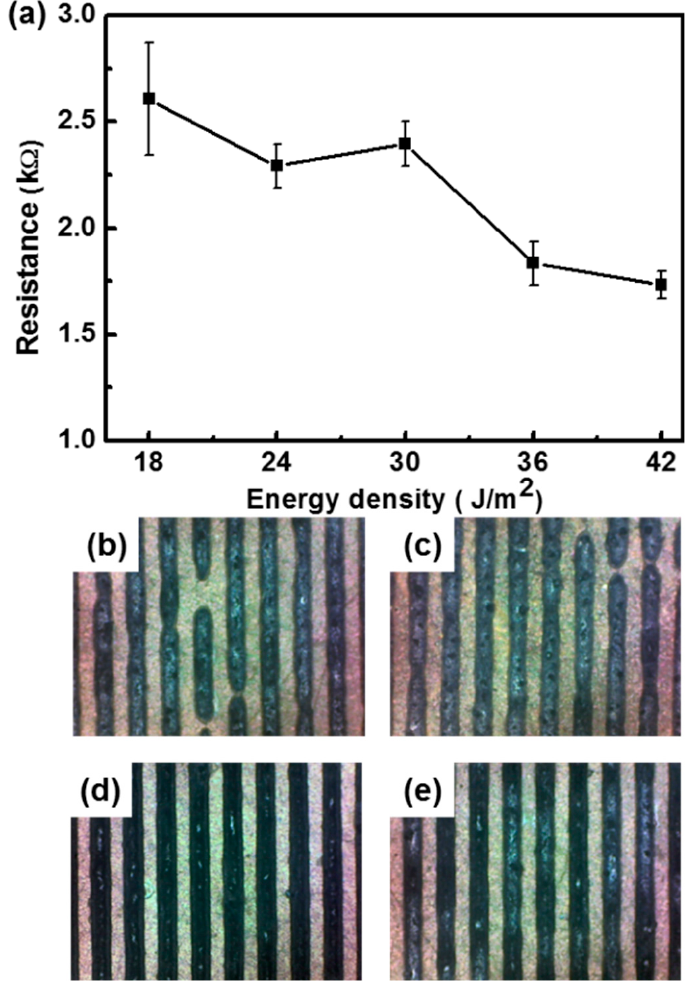
Figure 3. The patterned rGO-GO sheet resistance and optical image according to pulsed energy 6 J/cm 2 at one time. Sheet resistance ( a ), optical images of 24 J/m 2 ( b ), 30 J/m 2 ( c ) , 36 J/m 2 ( d ), and 42 J/m 2 ( e ).